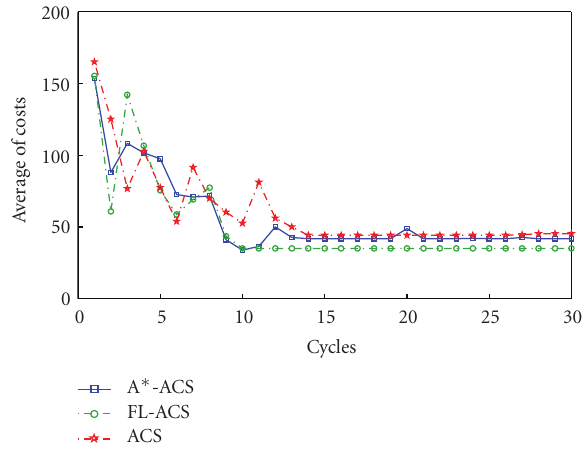
Figure 15: Average of 10 randomly selected O/D pairs cost averages for di ff erent “Tra ffi c” parameter importance rates. A comparison between performance of ACS, A ∗ -ACS, and FLACS algorithms is presented.